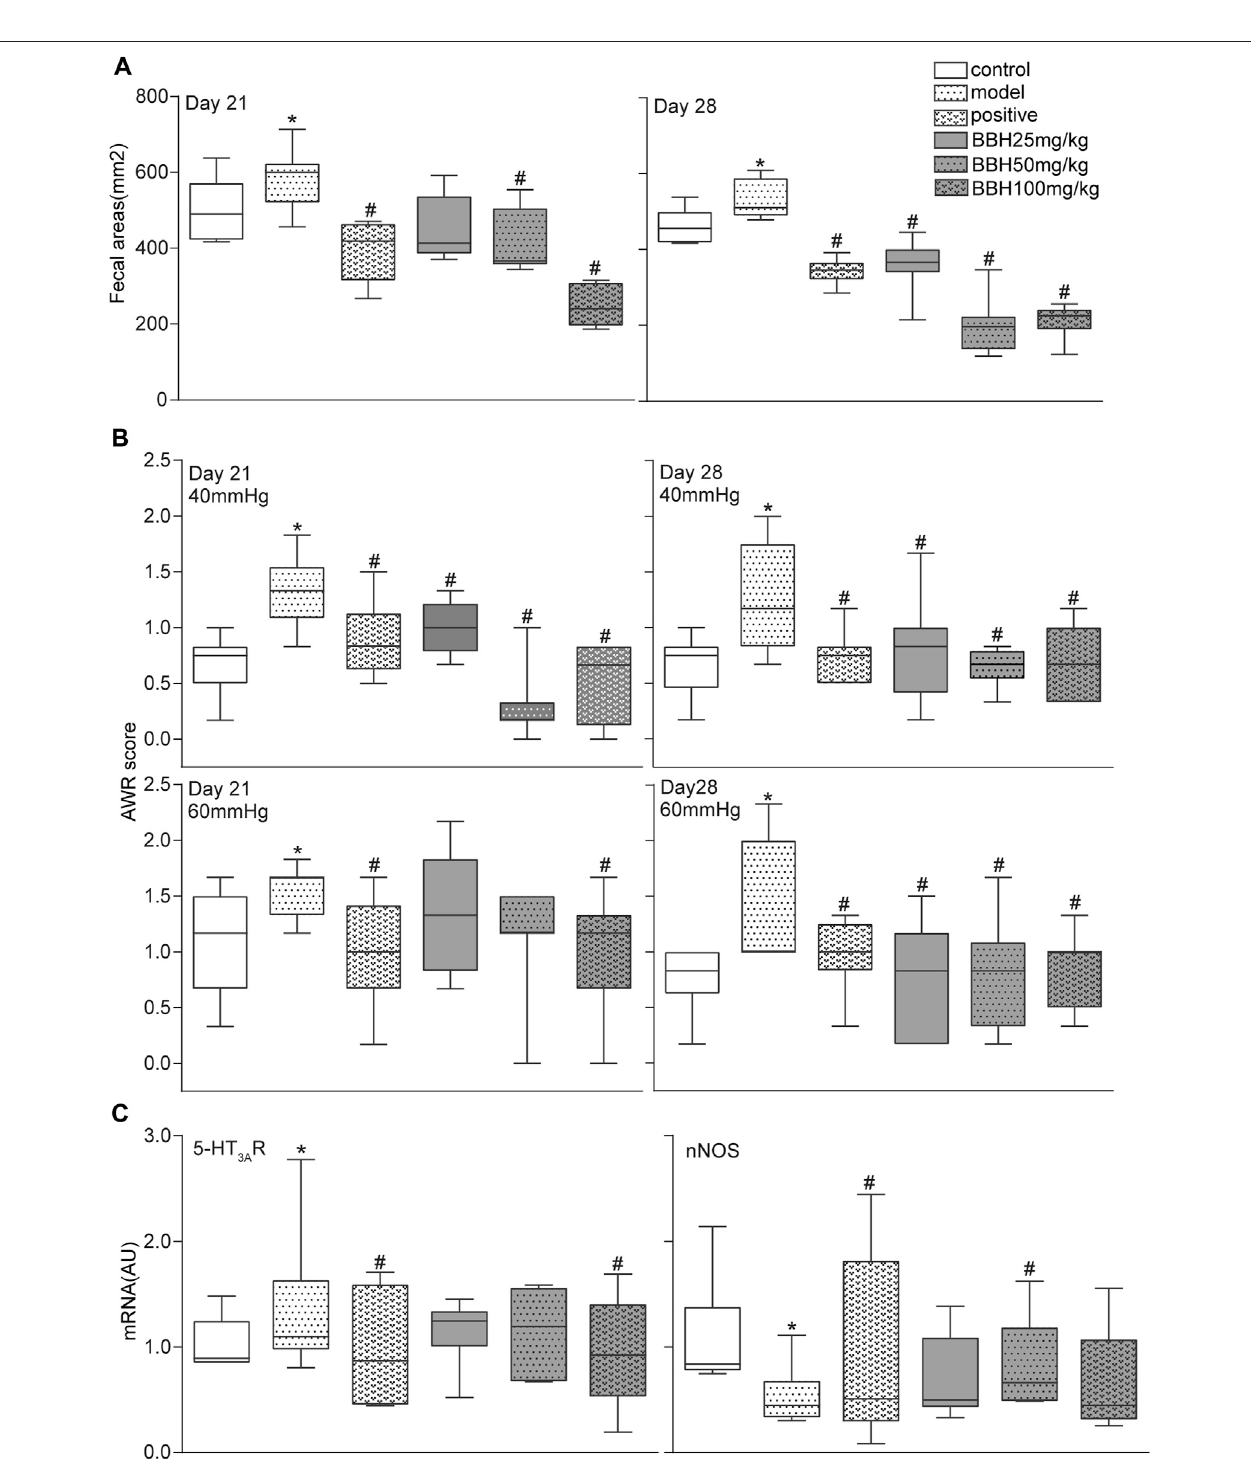
FIGURE4| BBHamelioratedsymptomsinIBS-Drats.Boxandwhiskerplotsofthedistribution andmeanoffecalareas,AWRscores,andtheexpression levelsof 5-HT 3A RandnNOSofthecontrolgroup,modelgroups,andfourtreatmentgroupsondays21and28.TheAWRscoresweremeasuredinresponsetogradedCRD(40 and 60 mmHg). n (cid:2) 6 – 12 rats per group. *denotes p < 0.05 compared with the control group. # denotes p < 0.05 compared with the model group.